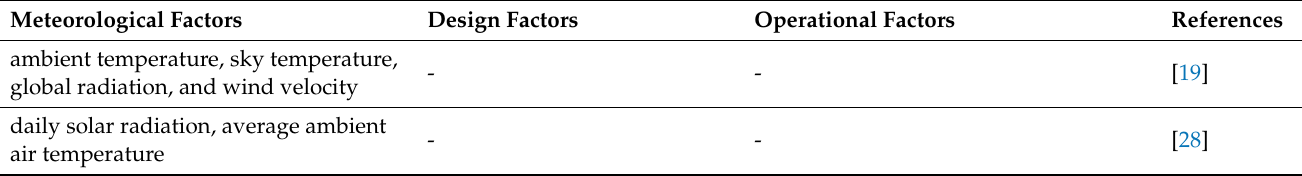
Table 1. Predictor variables used in previous regression